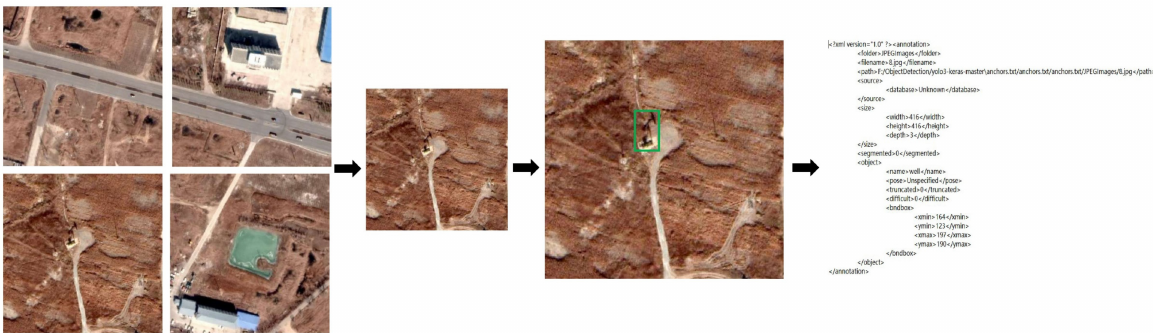
Figure 6. Process of marking oil well